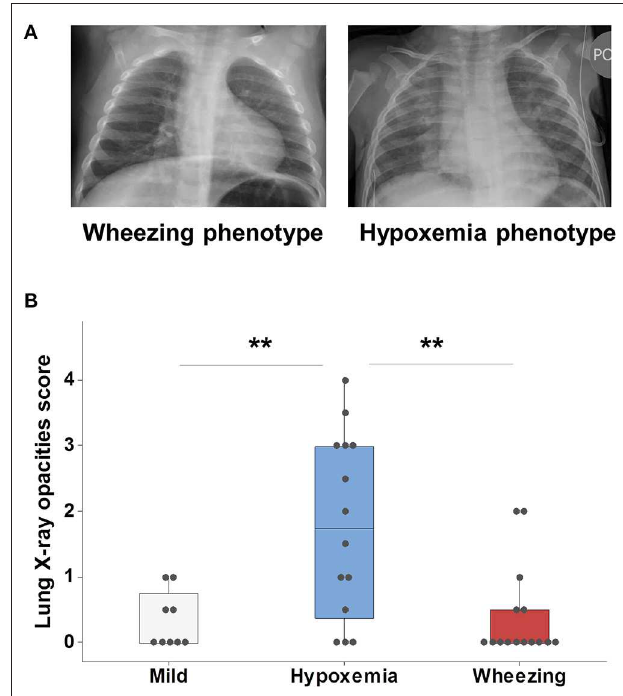
FIGURE 1 | Clinical phenotypes of severe viral respiratory infection using X-ray lung imaging. (A) Comparison of two cases of RSV infection; the case in the left side (wheezing phenotype) had wheezing/subcostal retractions and a CXR with increased perihilar markings and hyperinflation; the case in the right side (hypoxemia phenotype) had supplemental O2 needs and a CXR with multifocal alveolar opacities (right > left). (B) Analysis of all viral respiratory infection cases with available CXRs ( n = 38) demonstrated that individuals with a hypoxemia phenotype had more lung-X ray opacities. Boxes represent the 25 and 75th percentiles, ** p <